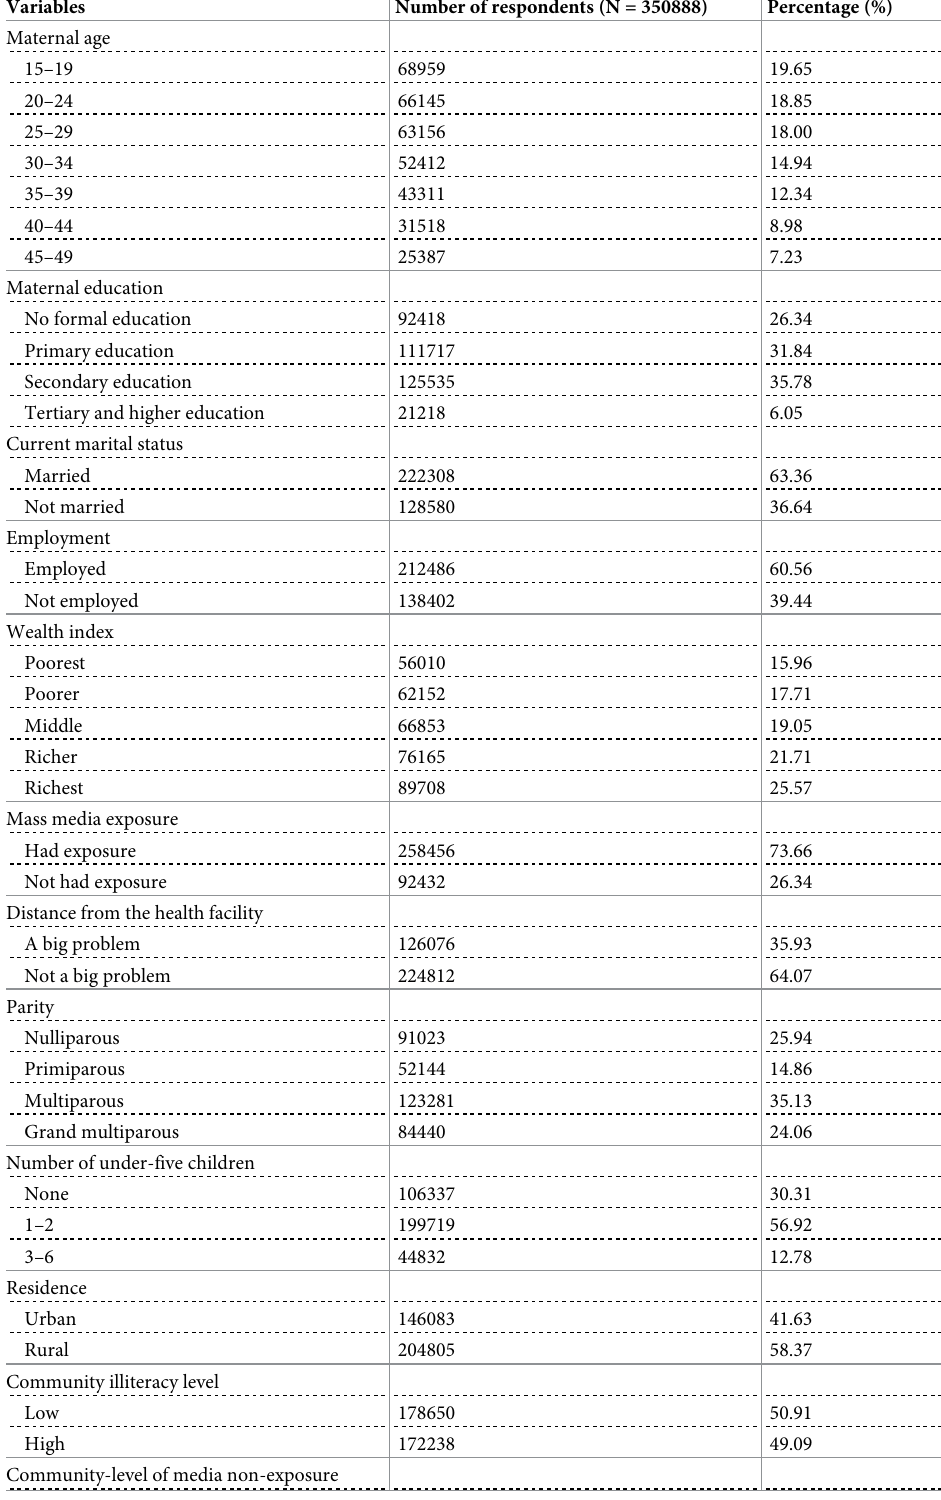
Table 1. Sociodemographic characteristics of